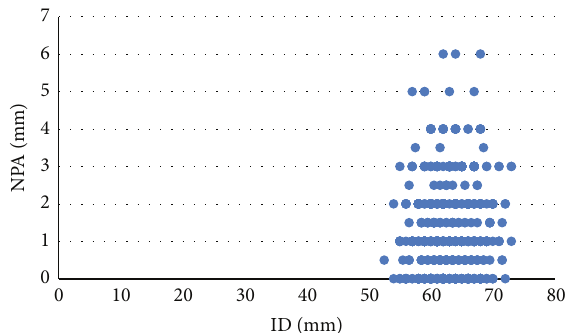
Figure 3: Correlation between the ID and the NPA. A very low correlation between both variables is observed ( 𝑟 = 0.074 , 𝑃 = 0.0